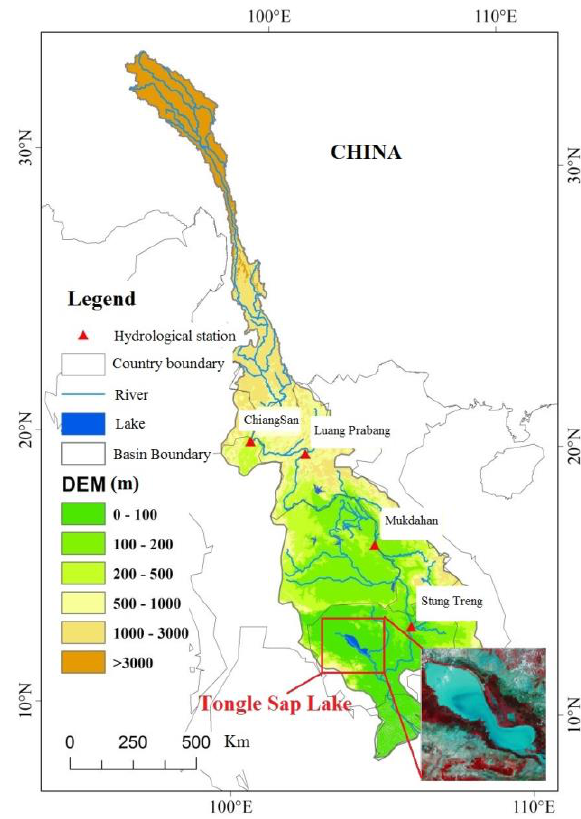
Figure.1 Location map of the Tonle Sap Lake and Mekong River Basin 3. METHODS